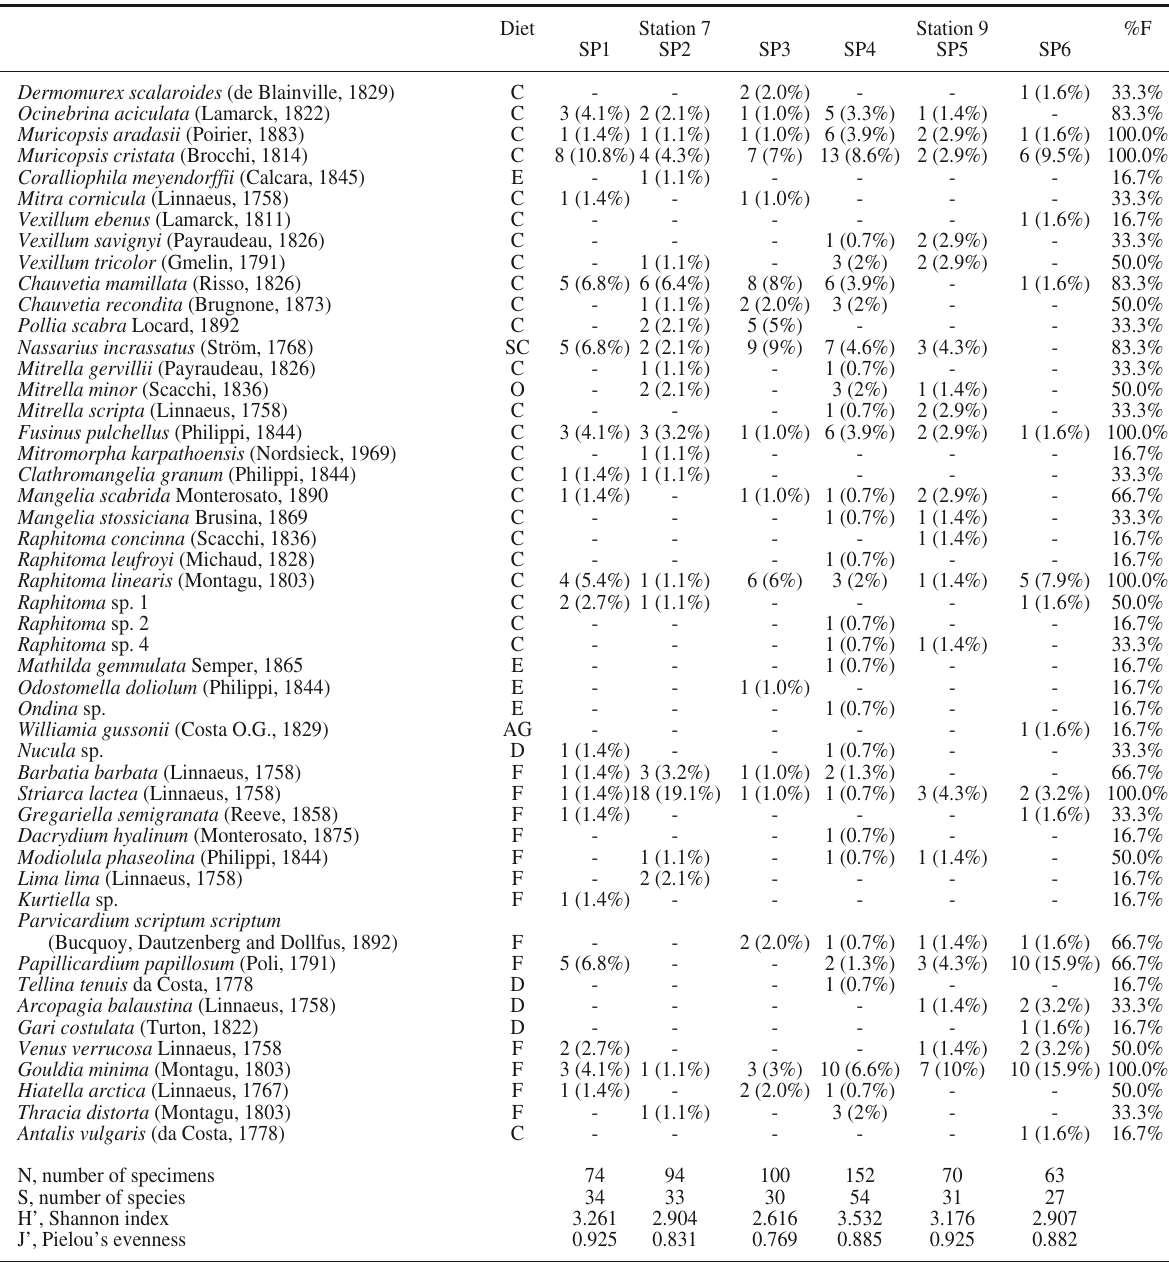
Table 4 (Cont.). – Faunistic list of molluscs found on the Posidonia rhizomes with quantitative data. The total number of individuals in each sample, the dominance index %D (between brackets), the frequency %F and the feeding guild code are given (C carnivores feeding on mobile organisms; SC scavengers; D deposit feeders; E ectoparasites and specialized carnivores; F filter feeders; AG macroalgae grazers; SG seagrass grazers; MG microalgal or periphyton grazers; O oophagus feeders; SY symbiont-bearing species). Biodiversity indices are reported at the bottom of the